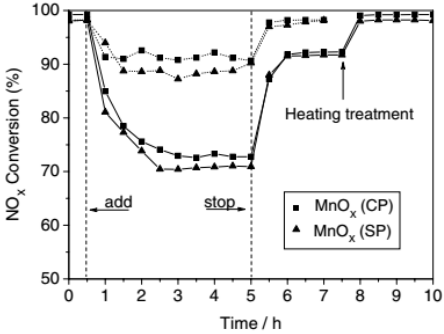
Figure 2. The effect of SO 2 and H 2 O on NO x conversion over MnO x (CP) and MnO x (SP) (dotted line: only added 10% H 2 O; solid line: added 10% H 2 O + 100 ppm SO 2 ). (Reproduced with permission from Reference [13], Copyright 2007,